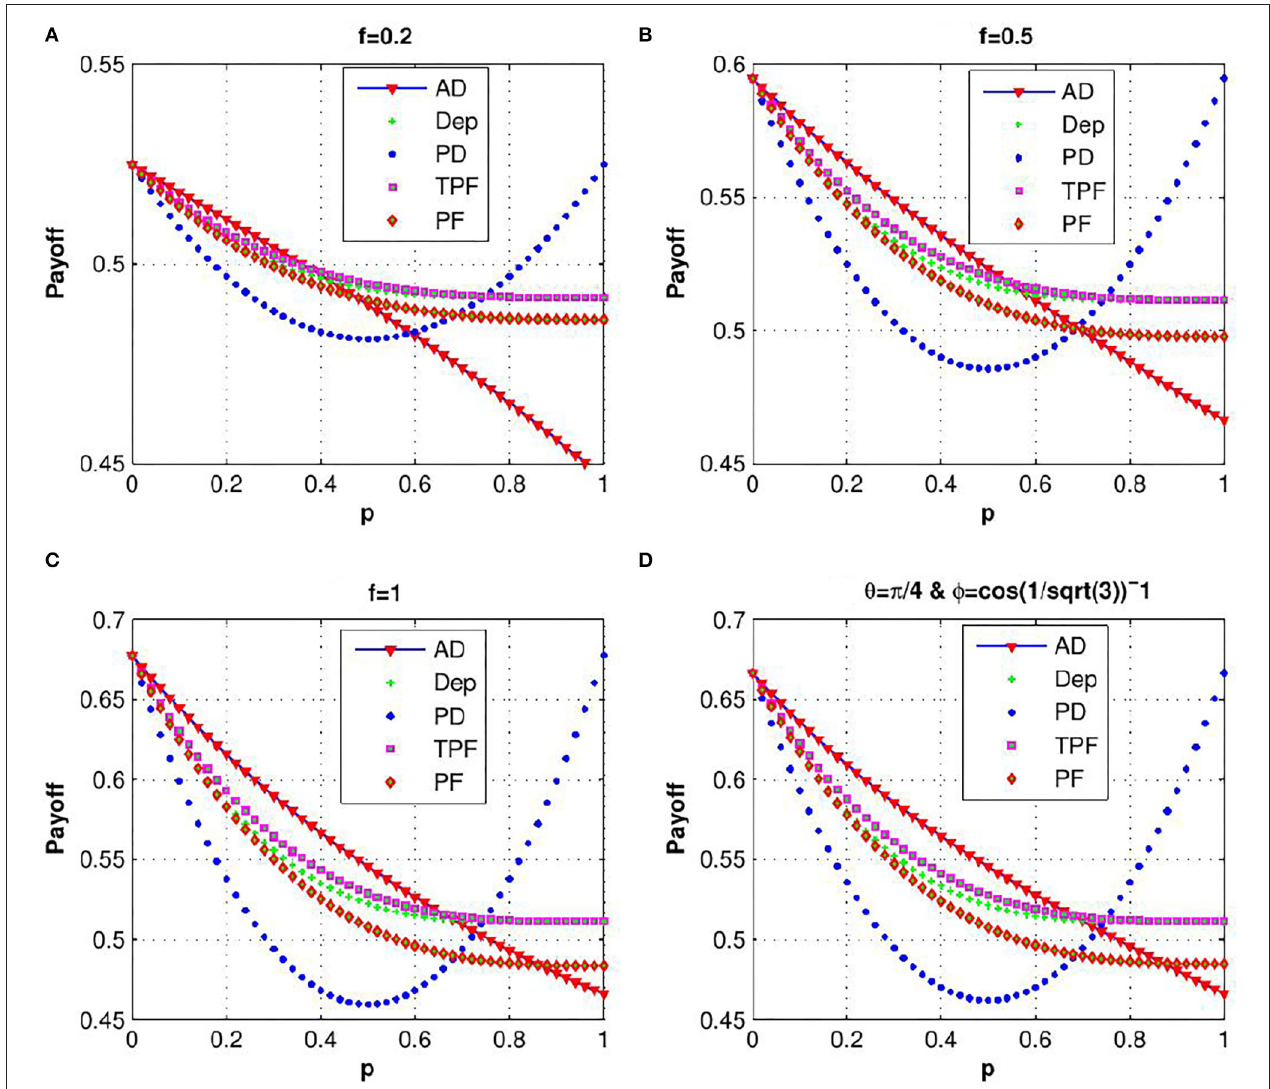
π 0.2, (B) f 0.5, (C) f 1, and (D) θ , 4 = = = =